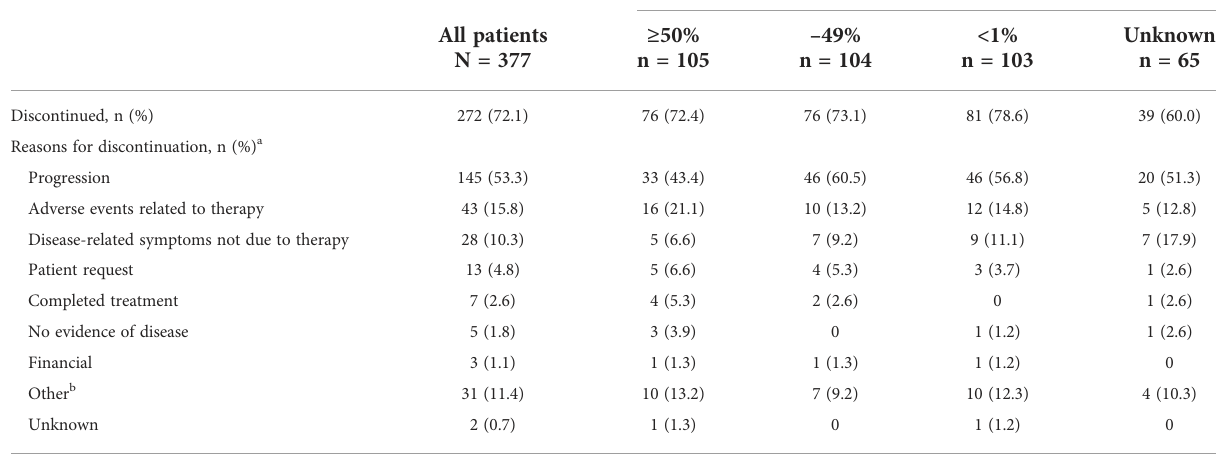
TABLE 3 Reasons for fi rst-line pembrolizumab discontinuation.